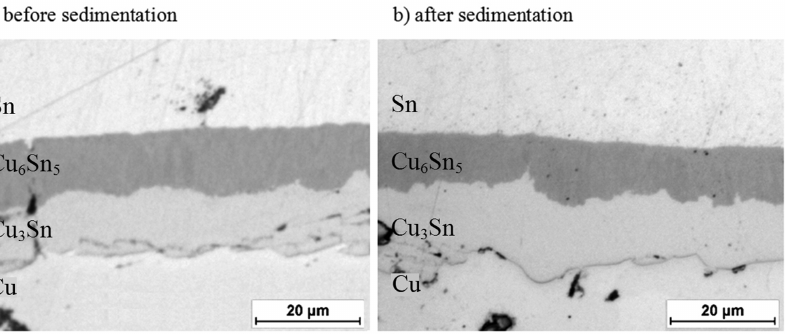
Figure 2: Cross-sectional image of the Cu-Sn system: (a) the initial sample for the sedimentation process – annealing at 200°C for 720h, (b) after sedimentation at 200°C for 24h.